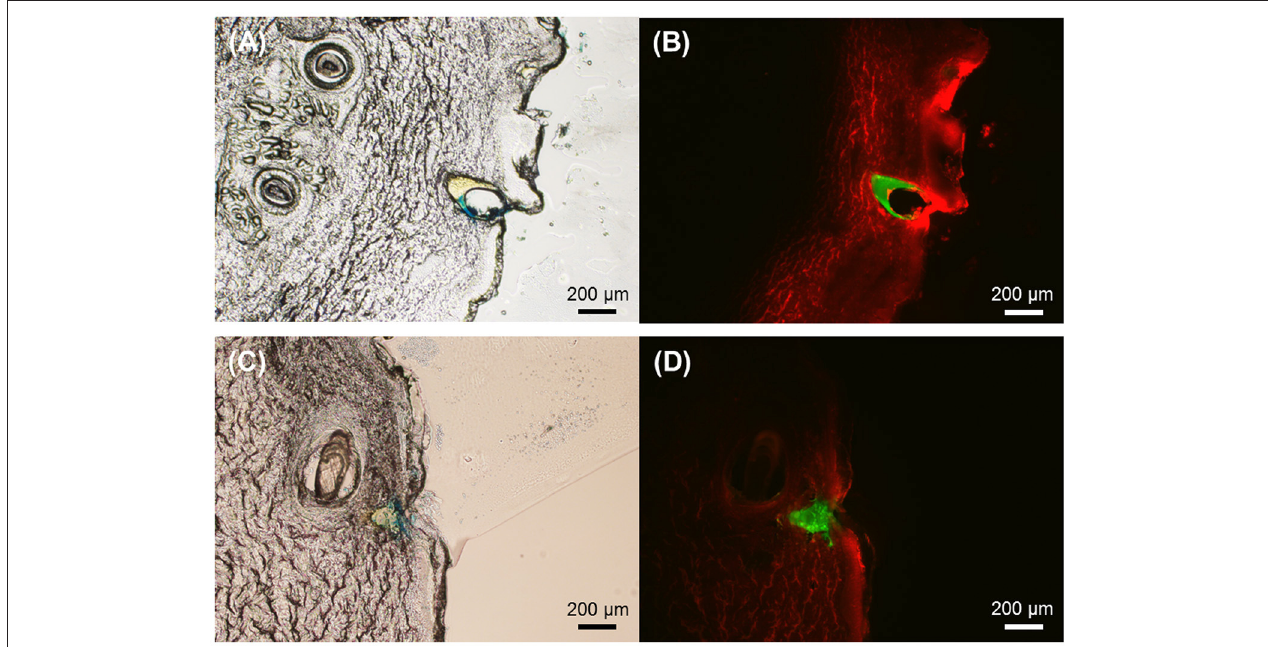
FIGURE 6 | Representative cross-sectional images of pig cadaver skin after insertion of PLGA-PVP multilayer microneedles. (A) The brightfield image and (B) The corresponding fluorescence image of the skin after insertion of circular obelisk microneedles. (C) The brightfield image and (D) The corresponding fluorescence image of the skin after insertion of beveled-circular obelisk microneedles. Fluorescence images show that the PLGA tips (green) remain intact in the skin while the PVP shafts (red) are completely dissolved. Scale bars represent 200 µ